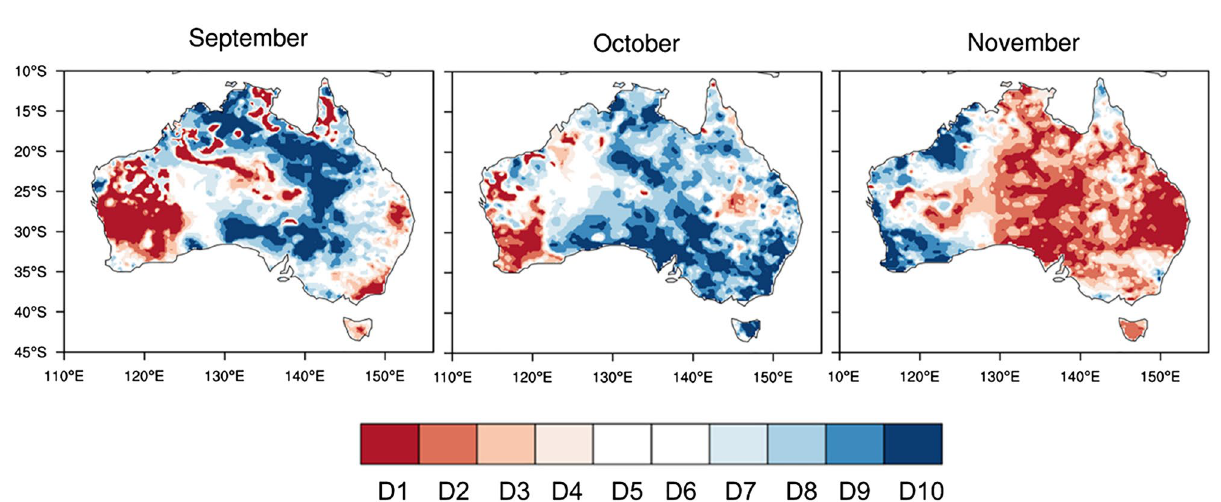
Figure 6. Rainfall decile maps of austral spring months. The decile thresholds were obtained from the period 1990–2012. Similar decile maps but based on the thresholds obtained from the full AWAP rainfall record since 1900 are available at http:// www. bom. gov. au/ clima te/ maps/ rainf all/? varia ble= rainf all& map= decil e& period= month & region= nat& year= 2020& month= 11& day= 30. Maps were generated using the NCAR Command Language version 6.6.2 (www. ncl. ucar.